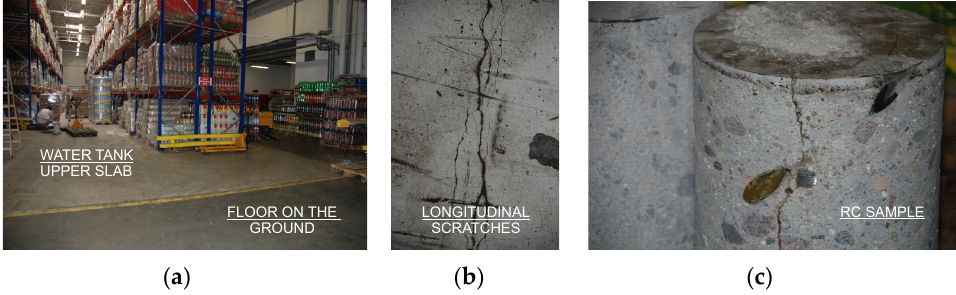
Figure 9. Shopping center warehouse: ( a ) slab-loading racks; ( b ) cracking of the top plate; ( c ) RC